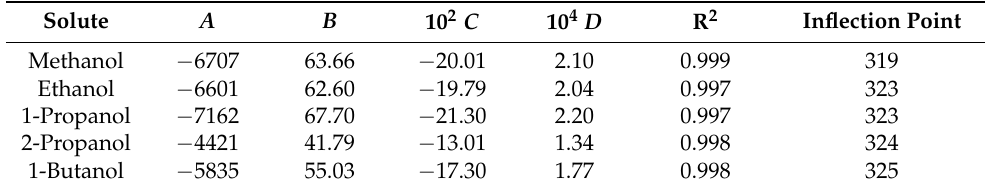
Table 3. Coefficients for third order polynomial fitting of the temperature dependance of the diffusion coefficients for short chain alcohols in supercritical carbon